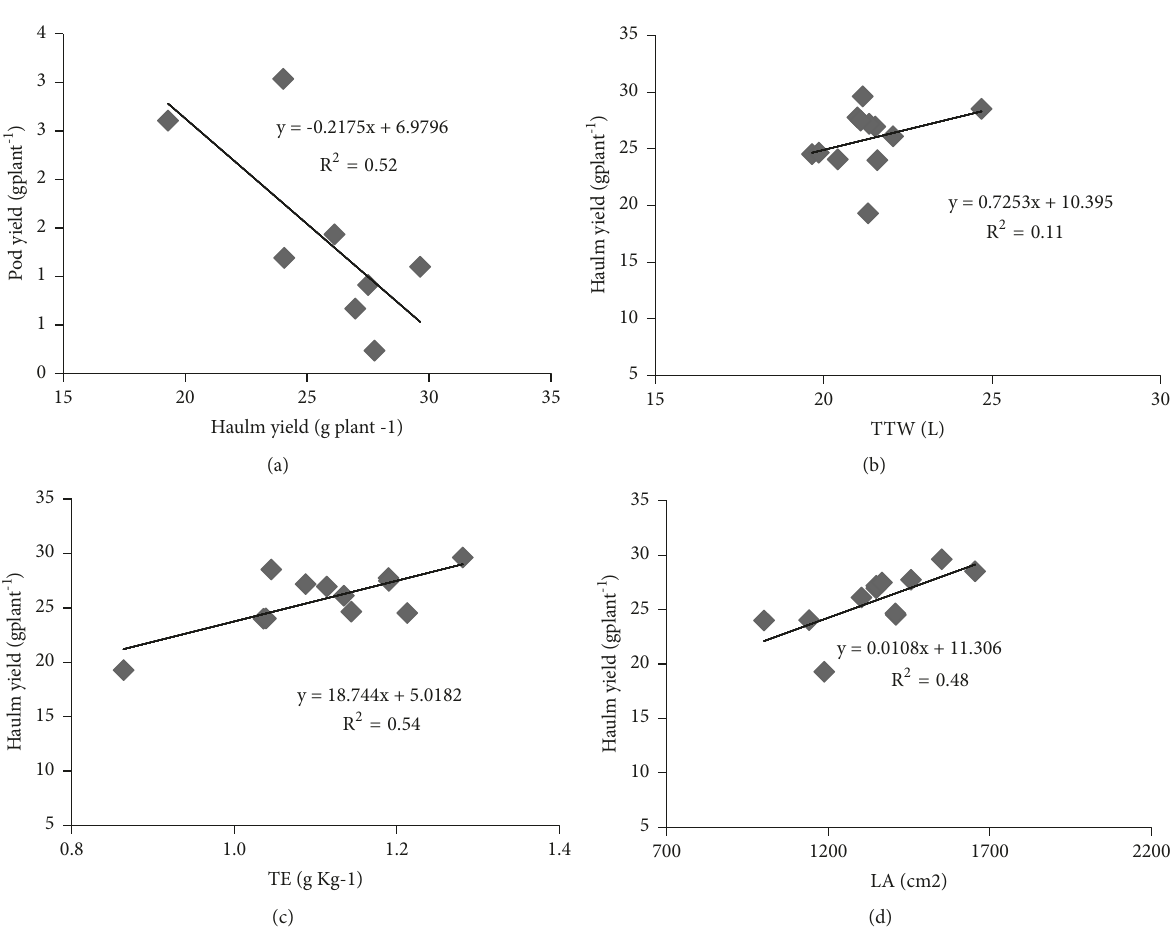
Figure 5: Relationship between pod and haulm weight (a) and between haulm weight and TTW (b), TE (c), and LA (d) under WS condition in lysimeter during year 2 experiment